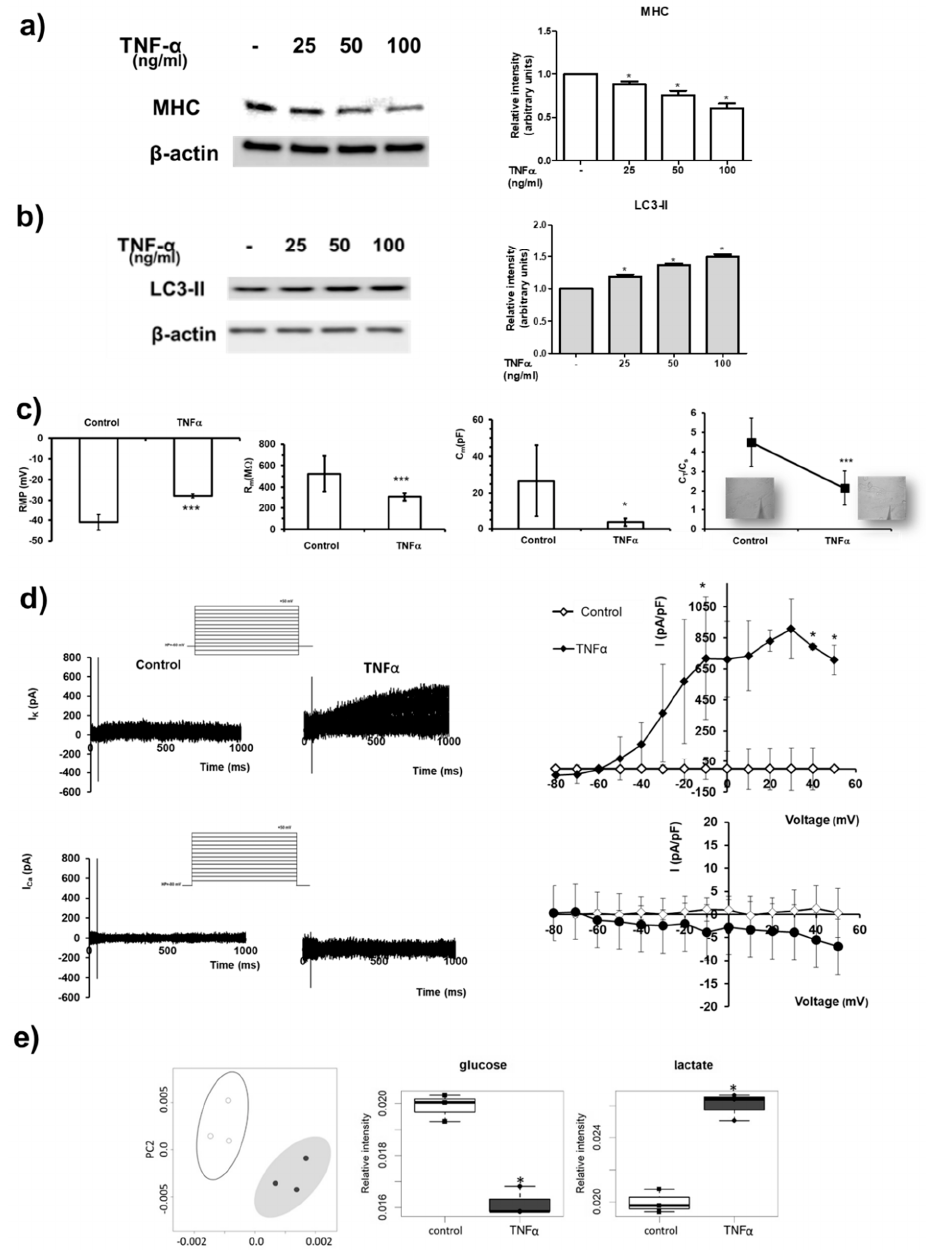
Figure 1. TNF α -induced atrophy in C2C12 myotubes. ( a , b ) C2C12 myotubes were treated with TNF α at the indicated concentrations (25-100 ng/mL) for 24 h. Western blot analysis was performed using specific anti-MHC ( a ) and anti-LC3 ( b ) antibodies in cell lysates. Left panels: blot representative of at least three independent experiments with analogous results is shown. Right panels: densitometric analysis of at least three independent experiments. Data are the mean ± SEM and are reported as protein expression normalized to β -actin, -fold change over control (set as 1). TNF α decreases the expression of MHC in a statistically significant manner by one-way ANOVA followed by Bonferroni’s post hoc test (* p < 0.05, treated vs. control). TNF α increases LC3-II in a statistically significant manner by one-way ANOVA followed by Bonferroni’s post hoc test (* p < 0.05, treated vs. control). ( c ) Resting membrane potential (RMP) evaluated in current-clamp mode, membrane resistance (R m ) and membrane capacitance (C m ) estimated in voltage-clamp and C T /C s ratio in the different